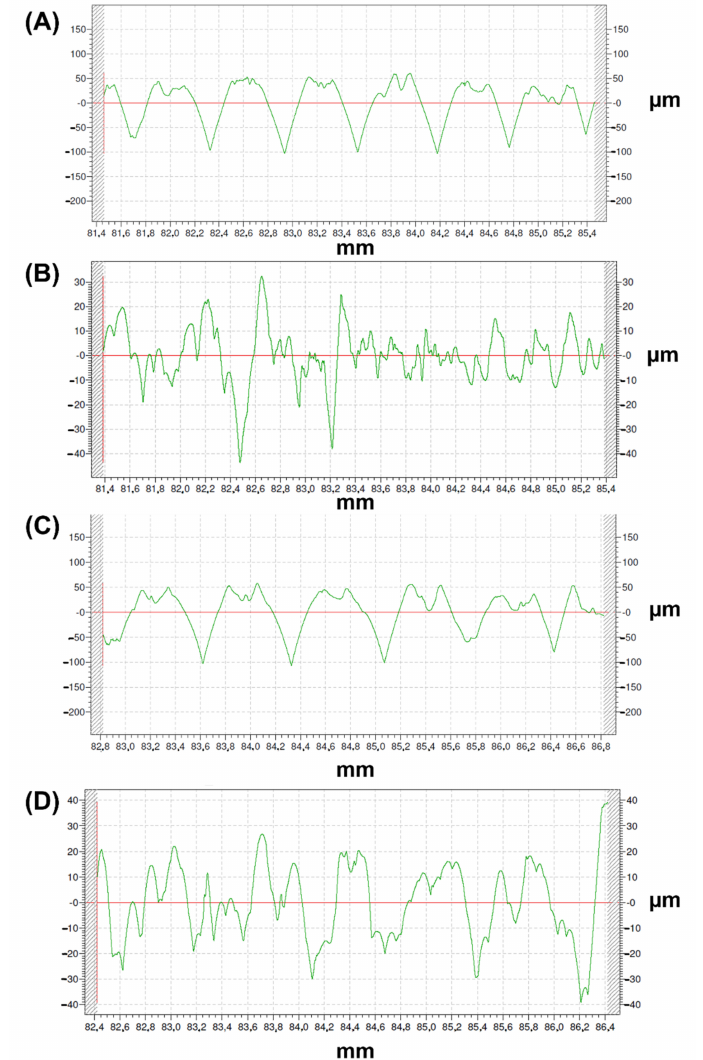
Figure 5. Roughness profiles of the steel-filled 3D printed samples. ( A ) 0.6 mm external roughness (first layer). ( B ) 0.6 mm internal roughness (second layer). ( C ) 0.7 mm external roughness (first layer). ( D ) 0.7 mm internal roughness (second